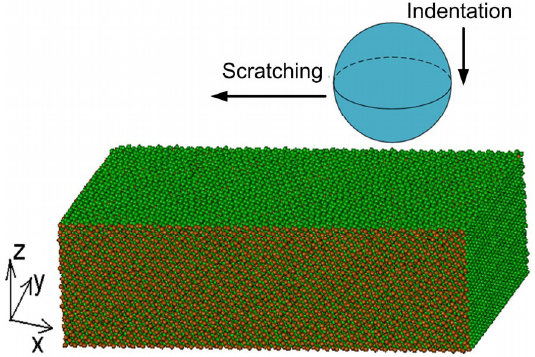
Figure 1. Model of molecular dynamics (MD) simulation. The green atoms and orange atoms are Ga atoms and As atoms, respectively.